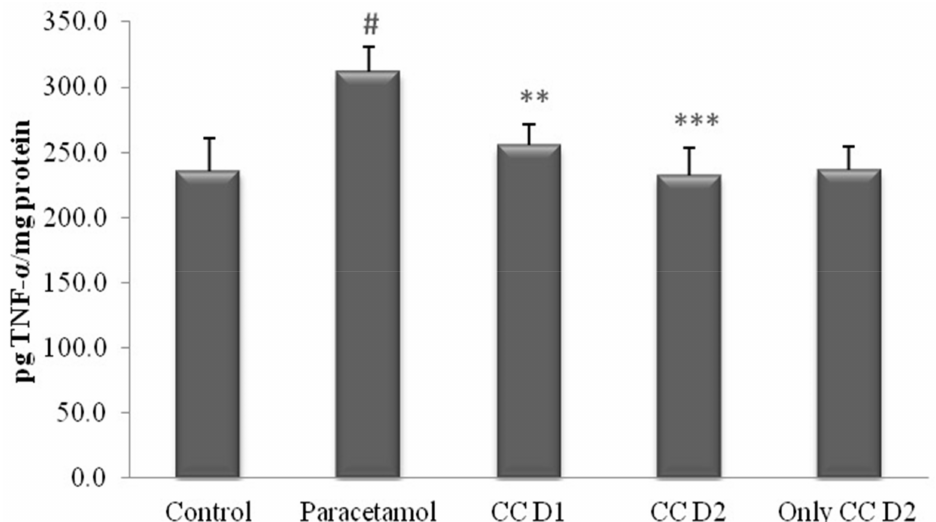
Figure 4. Expression of TNF- α in liver tissues of rats with Carum carvi treatment. Representative graph showing levels of TNF- α in rats treated with extract of Carum carvi . In this study, the mean ± SE (n = 6) is represented by each value. # p < 0.001 compared to control group. *** p < 0.001, and ** p < 0.01 compared to acetaminophen-treated group. D1 and D2: 100 and 200 mg/kg body weight dosage of Carum carvi , respectively.